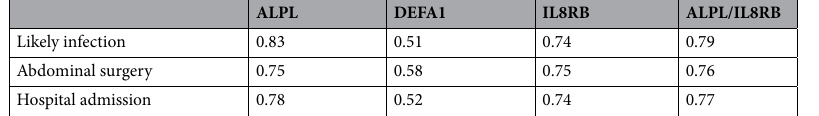
Table 3. AUC values to assess accuracy of biomarkers as continuous variables to predict outcomes in emergency department abdominal